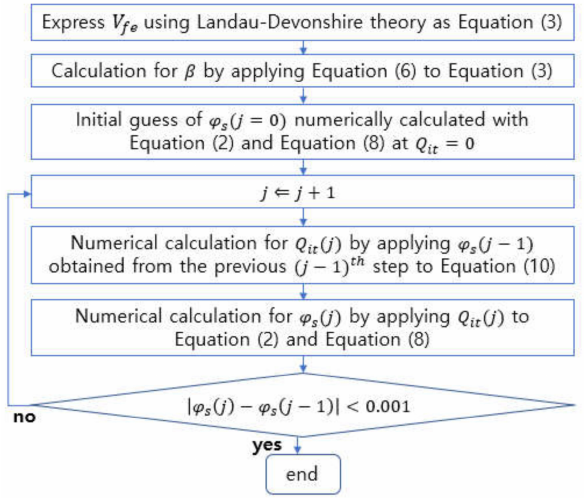
Figure 2. Flowchart for surface potential and interface trap charge of NC-GAA FET using self- consistent